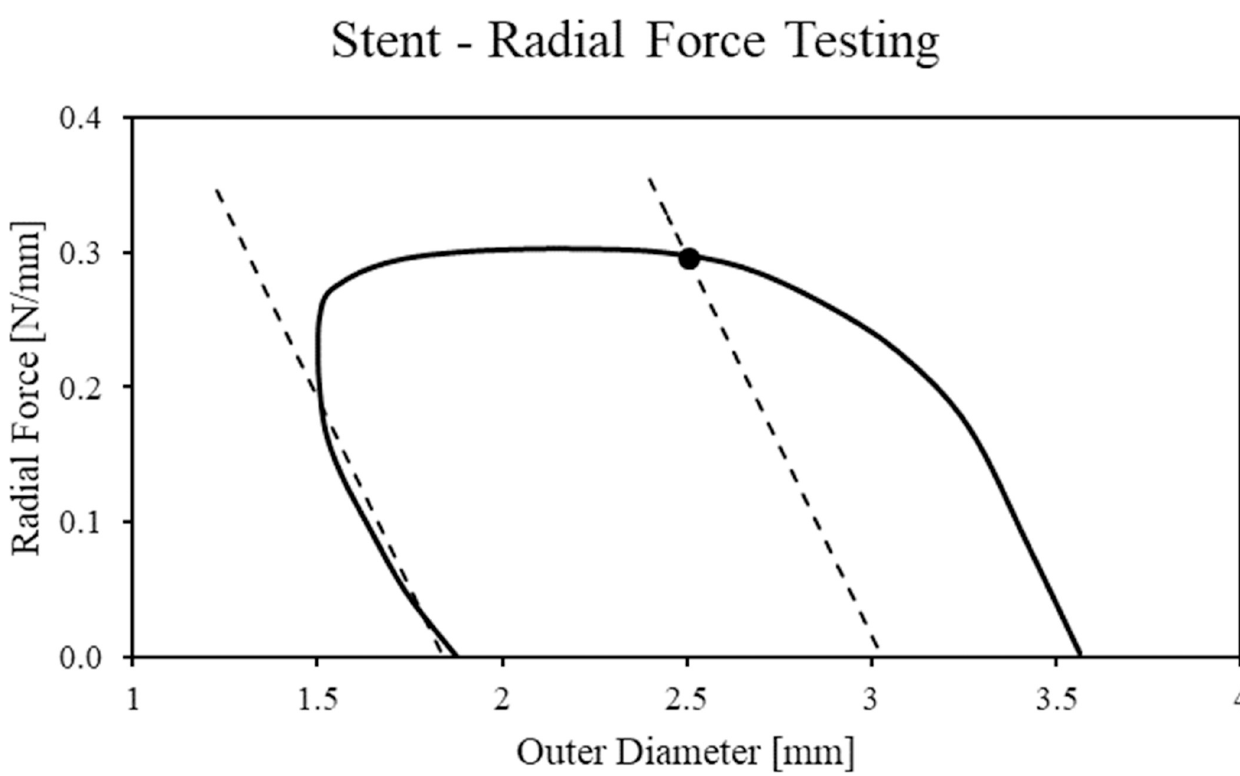
Fig 9. Numerical results of the recrimping simulation expressed in terms of diameter-radial force curve. A dashed line was used to indicate the slope of the curve during the unloading phase, which was used to find the intersection with the loading curve.